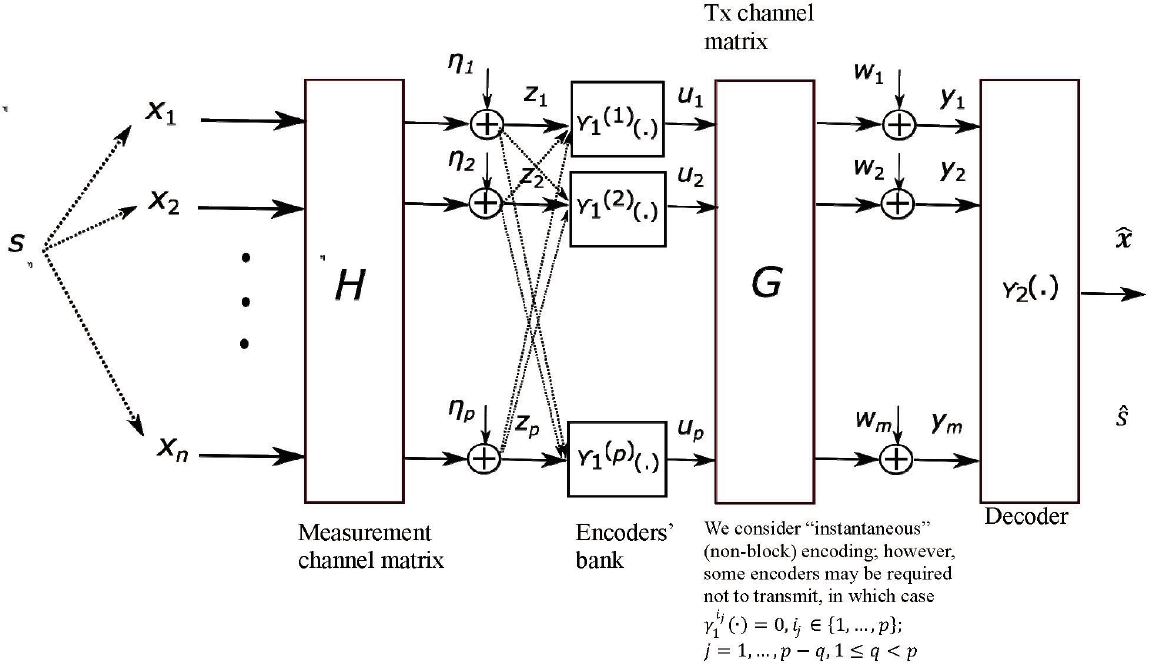
Figure 1. General structure of the WSN zero-delay coding/decoding